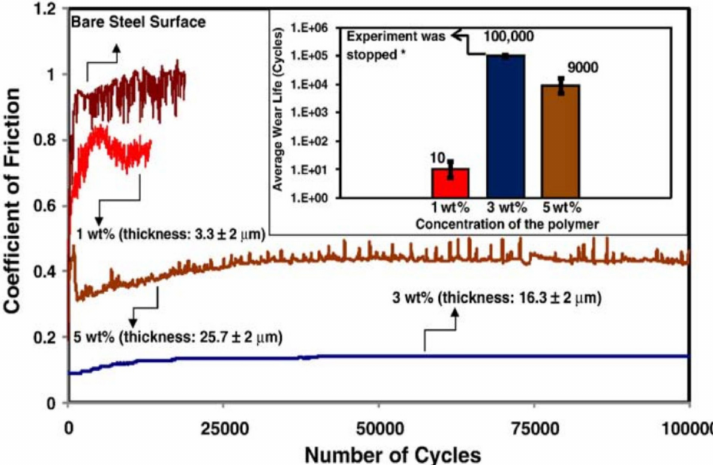
Figure 9. Typical coefficient of friction plots as a function of sliding cycles for different wt.% (different thicknesses) of UHMWPE at a normal load of 0.3 N and a rotational speed of 200 rpm. Inset: Average wear life for the three different thicknesses of the film [60]. Reproduced with permission from